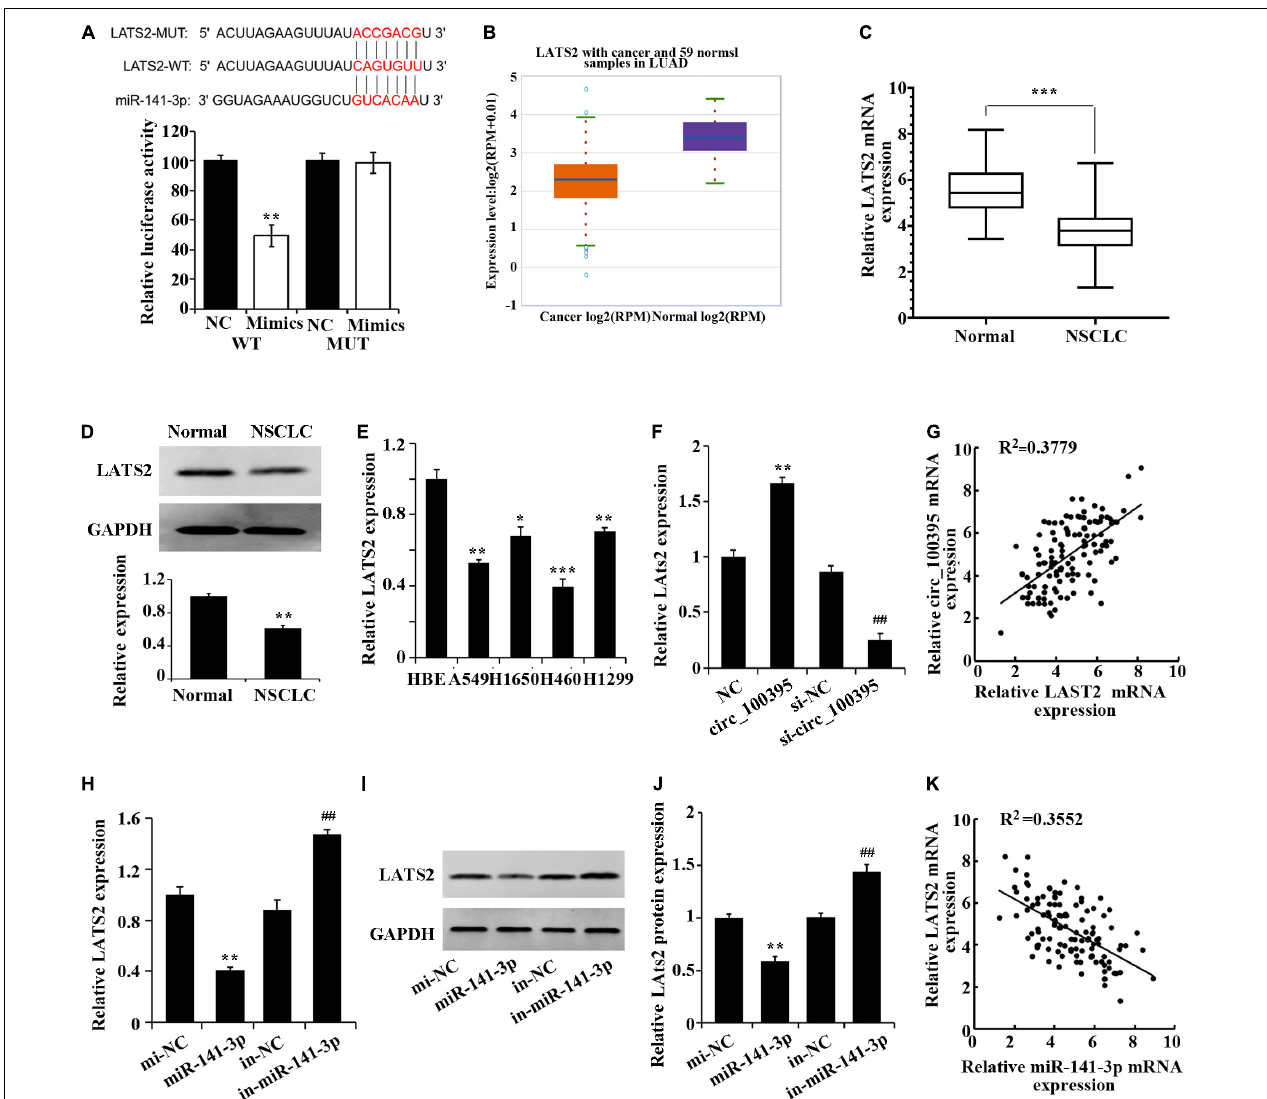
FIGURE 4 | Circ_100395 up-regulates LATS2 expression by competitively binding to miR-141-3p. (A) Confirmation of miR-141-3p targeting LATS2 gene via Dual-luciferase reporter assay. (B) LATS2 expression in NSCLC tissues in the StarBase3.0 database; (C) LATS2 expressed in paracancerous and NSCLC tissues qRT-PCR analysis. (D) LATS2 protein expressed in paracancerous and NSCLC tissues detected via western blot; * p < 0.05, ** p < 0.01, and *** p < 0.001 vs Normal group. (E) Expressed LATS2 in human bronchial epithelial cell line 16 HBE-T and NSCLC cell lines via qRT-PCR analysis, * p < 0.05, ** p < 0.01, *** p < 0.001 vs HBE. (F) qRT-PCR analysis of LATS2 expression in H1650 cells after overexpression and interference of circ_100395; ** p < 0.01 vs NC group, ## p < 0.01 vs si-NC group. (G) A beneficial relationship was found amidst expressed circ_100395 and LATS2 within tissues of NSCLC; (H) Expressed LATS2 post overexpression and interference of miR-141-3p discovered using qRT-PCR. ** p < 0.01 vs NC group, ## p < 0.01 vs si-NC group. (I,J) Expressed LATS2 protein in H1650 cells post overexpression and interference of miR-141-3p discovered using Western blot. ** p < 0.01 vs NC group, ## p < 0.01 vs si-NC group; (K) A contrary relationship was found amidst expressed miR-141-3p and LATS2 within tissues of